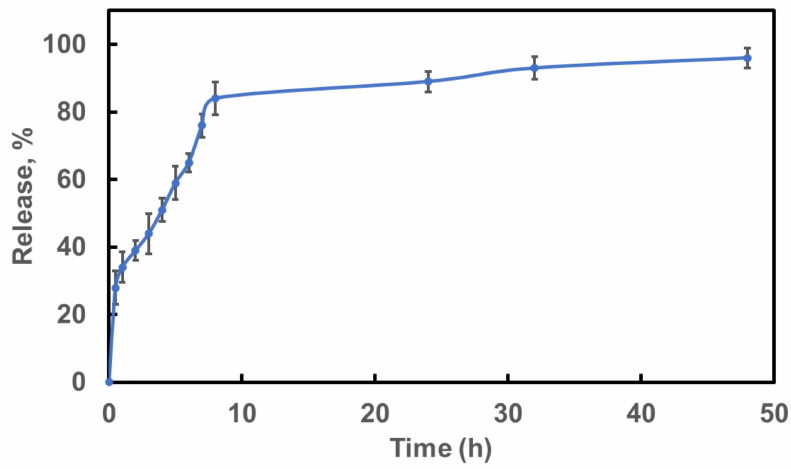
Figure 6. Permethrin release from the drug-halloysite composite in